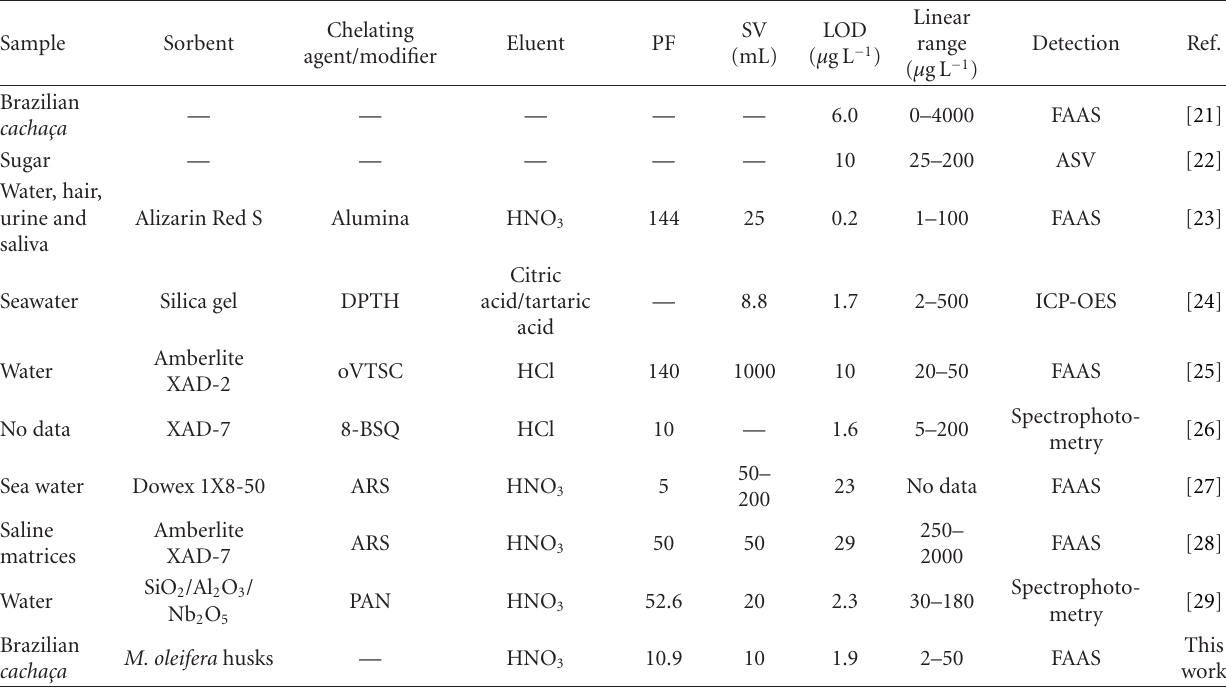
Table 4: Comparison of methods for determination of zinc.